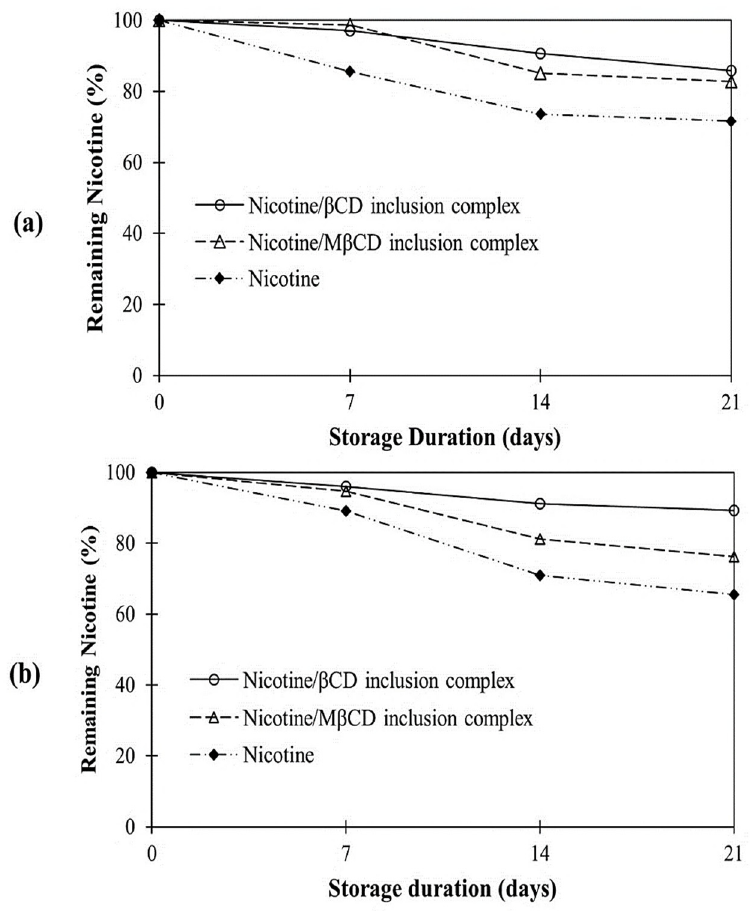
Figure 9. Preservation of nicotine in the form of a free compound and inclusion complexes ( a ) at 25 ◦ C and ( b ) at 40 ◦ °C and ( b ) at 40 °C. 25